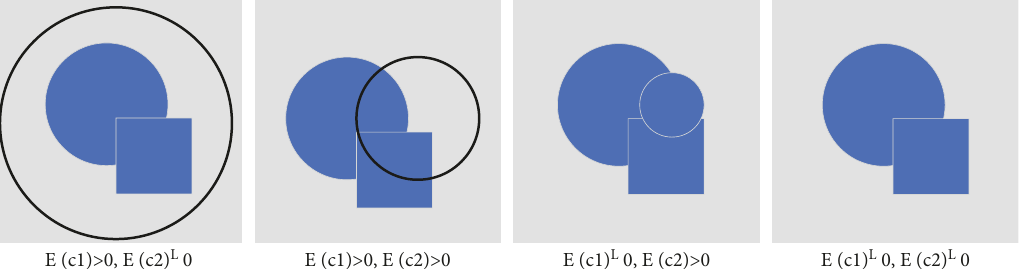
Figure 3: Schematic diagram of the segmentation of the C-V model.